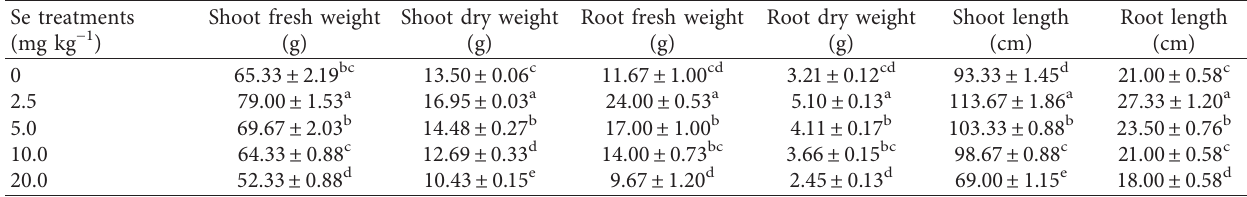
Table 2: Effect of different selenium levels on plant growth parameter of maize. Se treatments